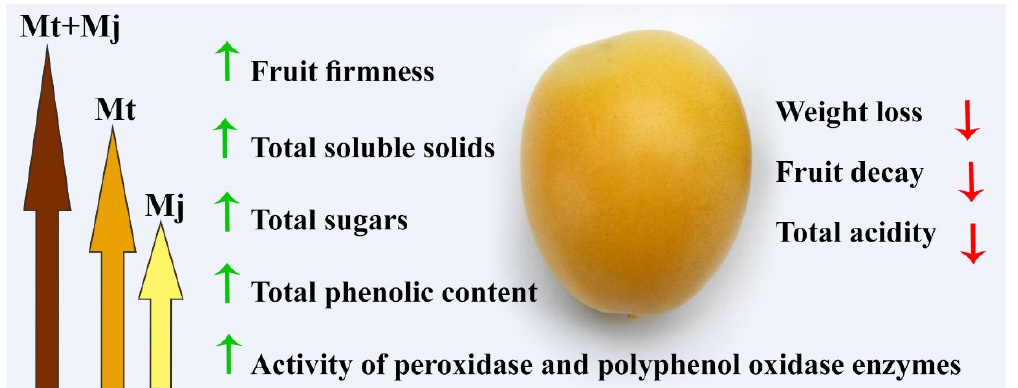
Figure 4. Schematic figure illustrating the main results obtained in this study. Where, Mj = methyl jasmonate, and Mt = melatonin.